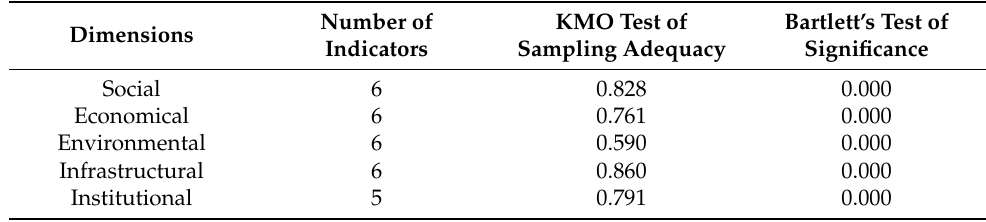
Table 2. Principal component analysis results of KMO and Bartlett’s test for indicators within each resilience